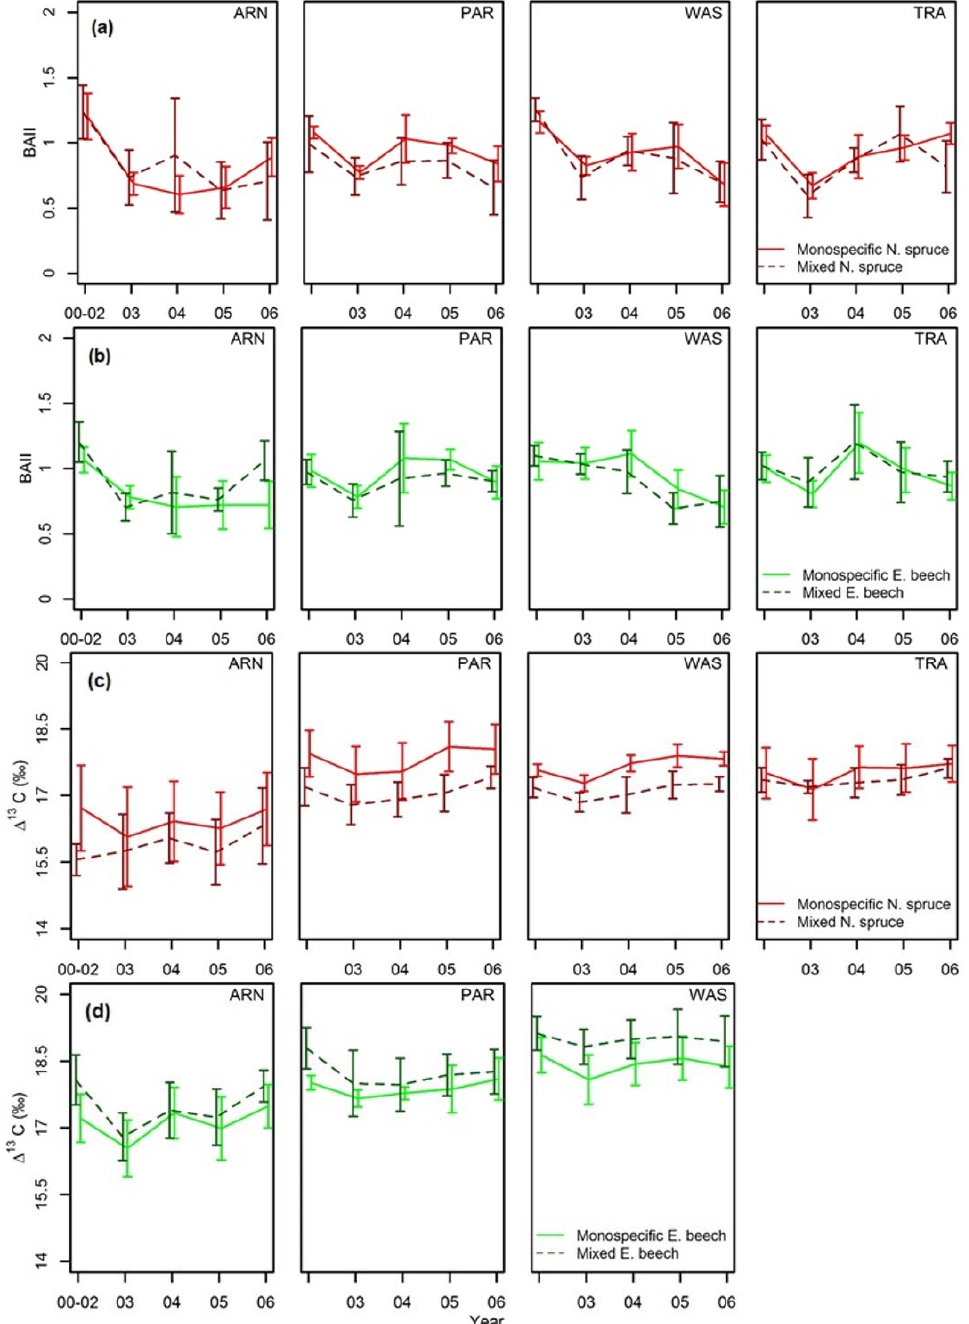
Figure 2. Standardized mean basal area increment (BAII) ( a , b ) and mean Δ 13 C ( c , d ) (for the period 2000 to 2006) of spruce and beech in monospecific and mixed neighborhood at the sites Arnstein (ARN), Parsberg (PAR), Wasserburg (WAS), and Traunstein (TRA) with confidence intervals (CI,